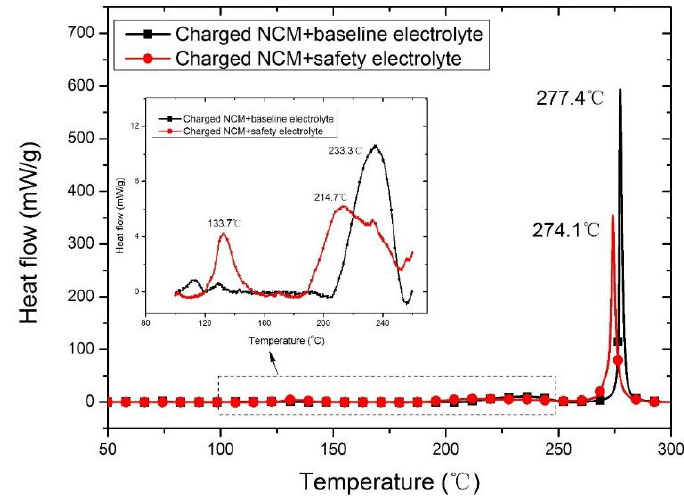
Figure 1. C80 heat flow of NCM-baseline electrolyte and NCM-safety electrolyte system in argon filled vessel at a 0.2 °C/min heating rate. The NCM were extracted from NCM/safety electrolyte/Li and NCM/baseline electrolyte/Li half cells at 4.2 V.